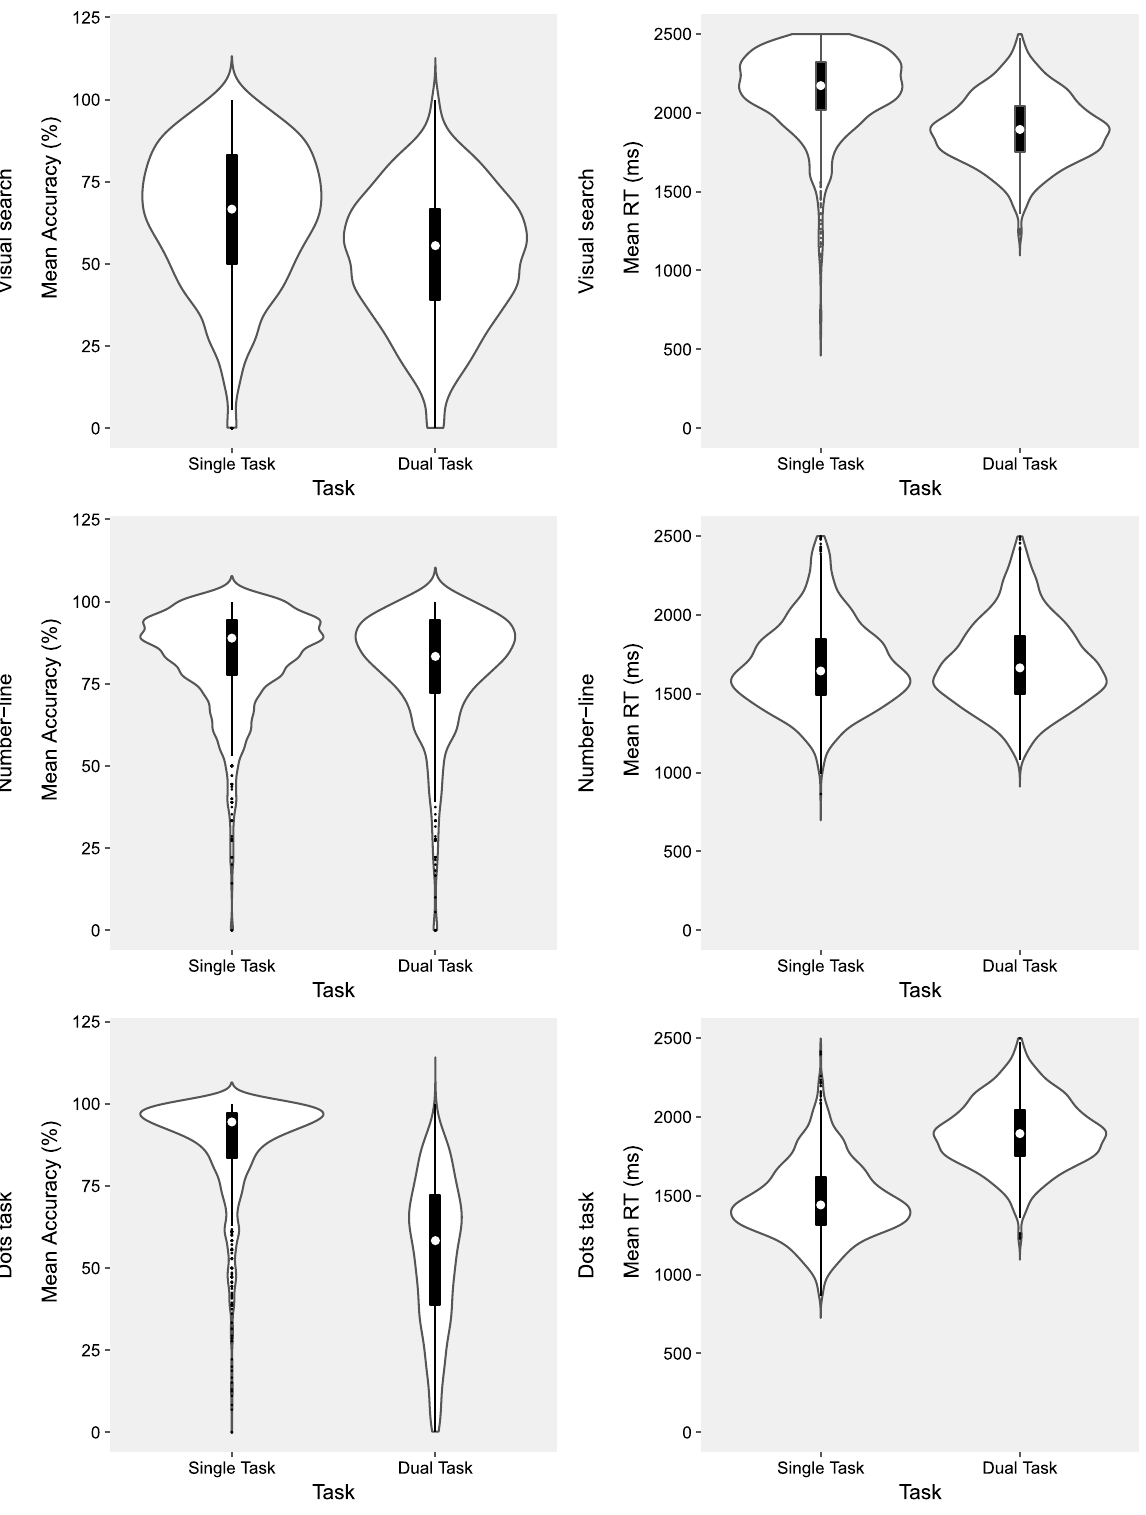
Figure 3. Violin plots of distributions for accuracy (percent correct; left column) and reaction time (in milliseconds; right column). ( A ) Visual search task. ( B ) Number-line estimation task. ( C ) Dot enumeration task. The white circle in each plot represents the median, the black band represents the first quartile (lower) to third quartile (upper), and the highlighted white area represents the density trace of